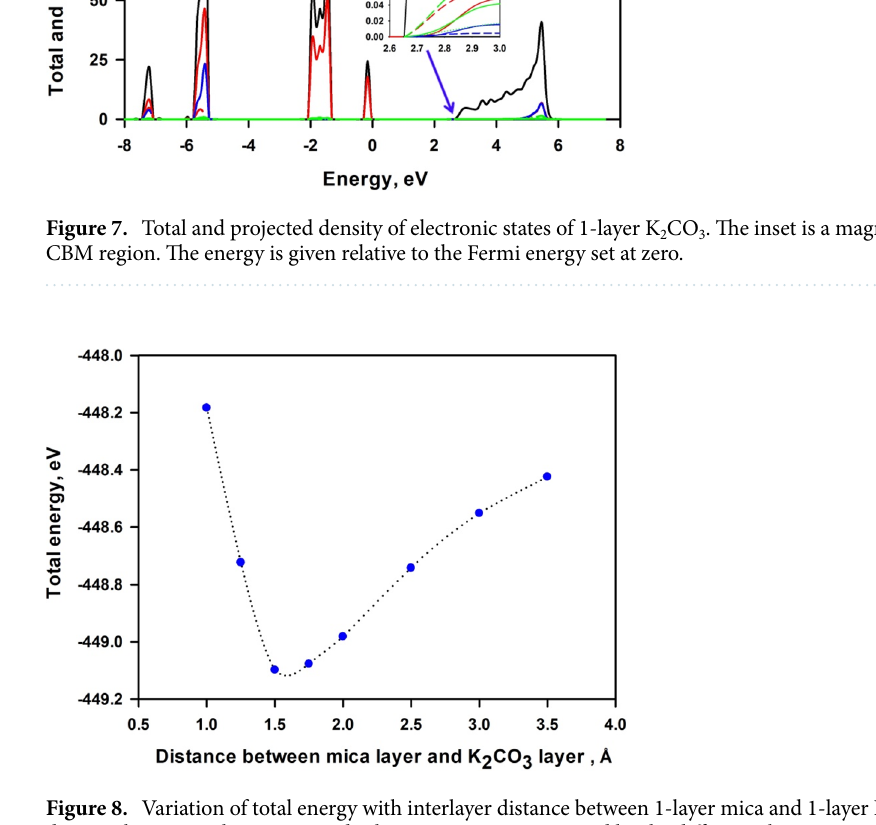
Figure 8. Variation of total energy with interlayer distance between 1-layer mica and 1-layer K 2 CO 3 . Interface distance between 1-layer mica and 1-layer K 2 CO 3 is represented by the difference between averaged z coordinates of atoms in the bottom-most of K 2 CO 3 and in the top-most of